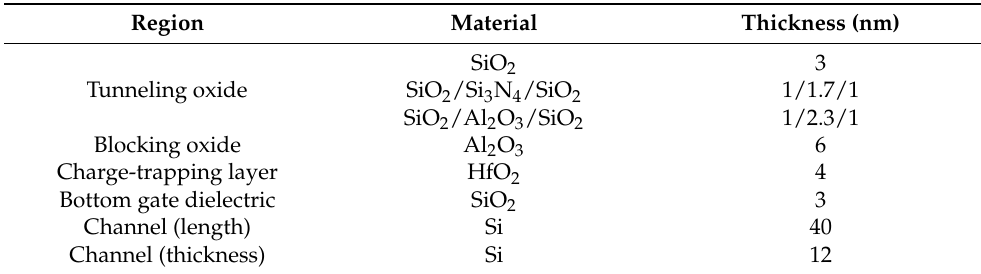
Bottom gate Table 1. Film thickness and channel length in conventional TAHOS, BE-TAHOS, and proposed TAHOAOS structure.